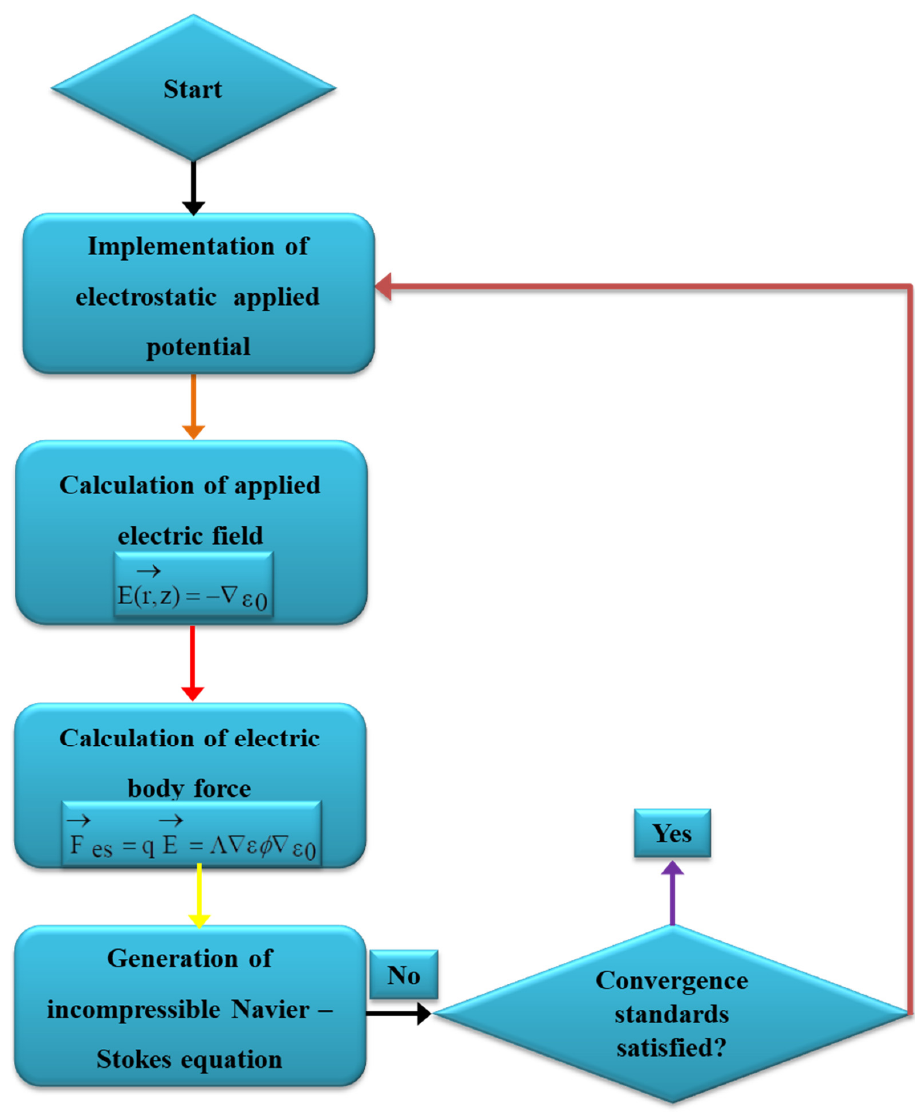
Figure 2. Flowchart of phase-field simulation .